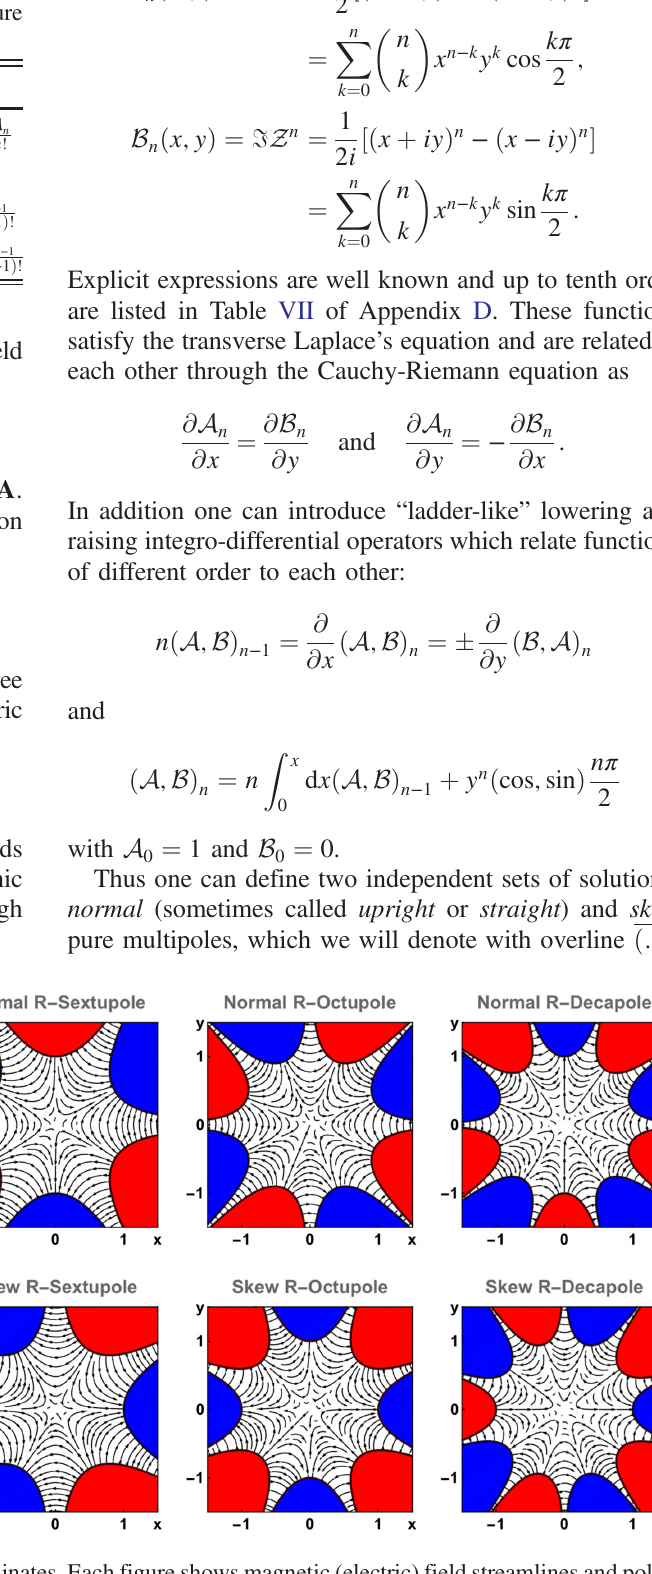
FIG. 2. Normal and skew 2 n -pole magnets in Cartesian coordinates. Each figure shows magnetic (electric) field streamlines and poles ’ shape in transverse cross section. North (positive electrostatic potential) and south (negative electrostatic potential) poles are shown in red and blue and are given by ð B ; A Þ n ¼ ∓ R n respectively, where R is the distance to the pole ’ s p p